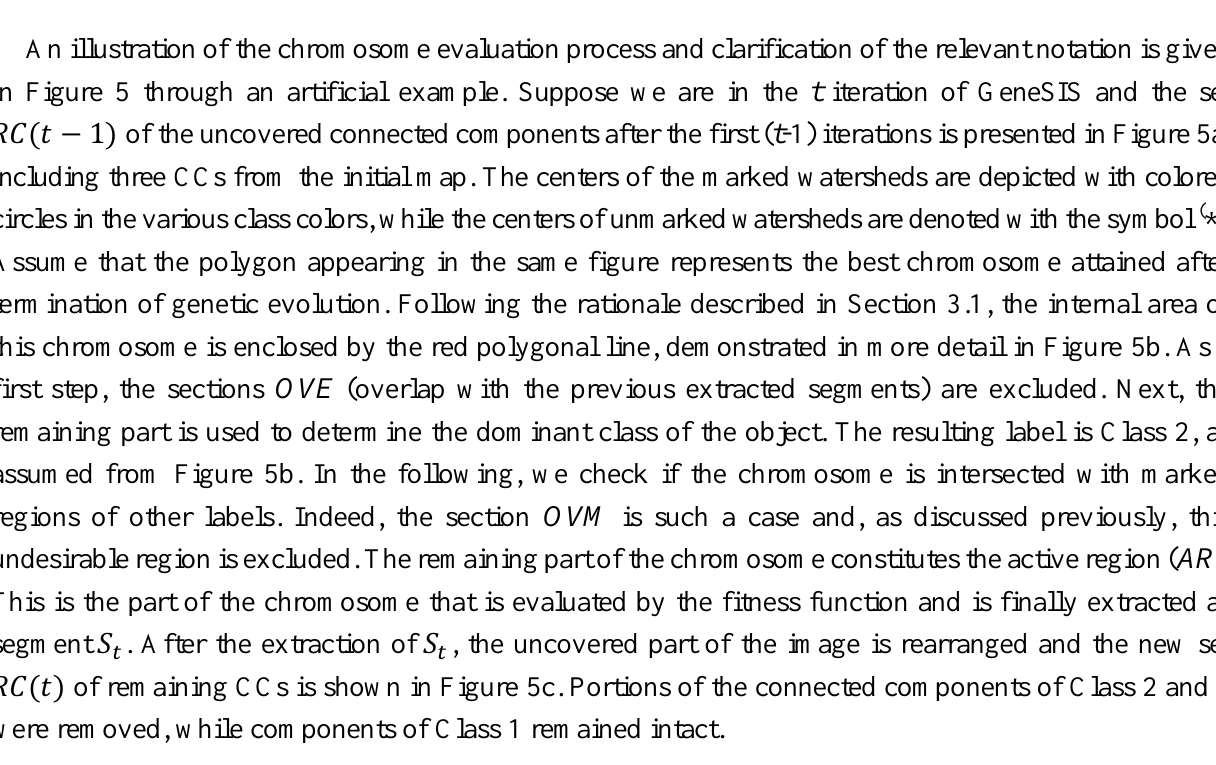
Figure 5. Illustration of an object extraction (iteration t ): ( a ) set of uncovered connected components 𝑅𝐶(𝑡 − 1) , ( b ) internal of the elite chromosome, ( c ) modified set of uncovered connected components 𝑅𝐶(𝑡)